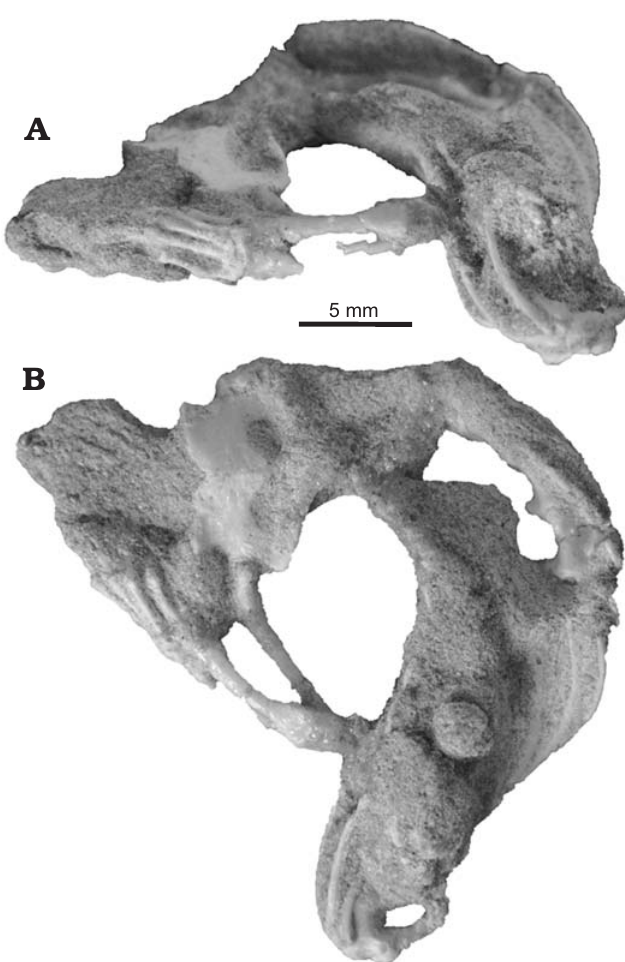
Fig. 11. The stem-amphisbaenid Slavoia darevskii Sulimski, 1984 (PIN 3142/358, posterior half) from late Campanian of Mongolia; displaying nearly complete hindlimb and ischia. Photograph from the rear showing reduced pes ( A ), ventral side ( B ). Photos courtesy of Vladimir